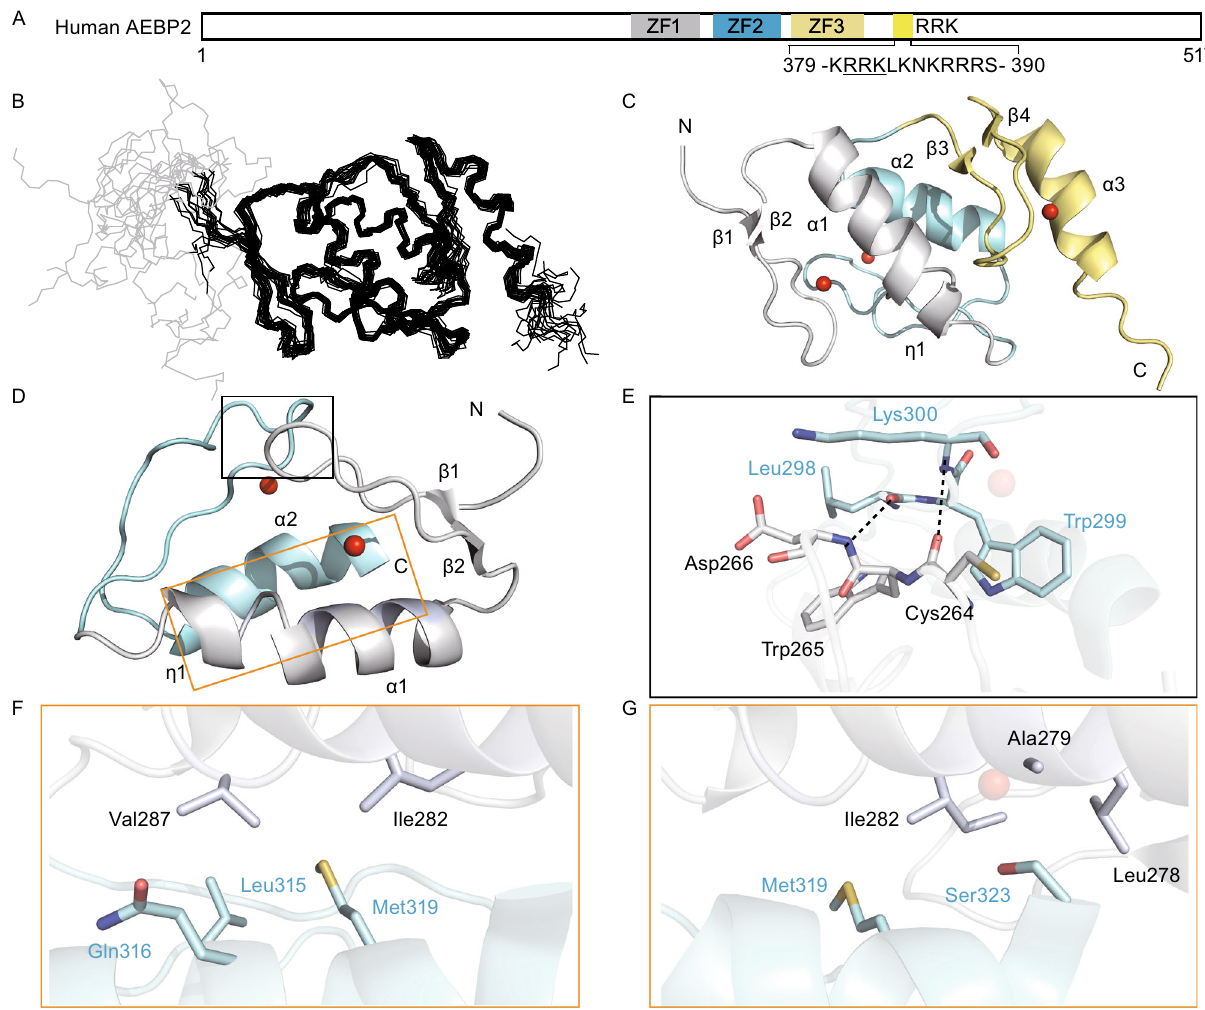
Figure 1. All three zinc fi ngers of AEBP2 are composed of Cys2His2 zinc fi ngers . (A) Schematic representation of the human AEBP2 protein, including the three zinc fi ngers and RRK rich motif. The fi rst zinc fi nger is shown in gray bar, second in light blue bar and third in light yellow, respectively. The RRK rich motif is shown in yellow bar, with sequence shown as single letter amino acids. (B) Stereo image of the 20 lowest energy ZF1 – 3 backbone structures (PDB ID: 5Y0U). The overall structure is depicted, with the His 6 - tag shown in gray. (C) Cartoon representation of ZF1 – 3 highlights the secondary structural elements, color scheme as for (A), and spheres are zinc ions. (D) Overview of ZF1 – 2 packing as tCWCH2 domain. The inter-zinc fi nger interaction regions are squared with gray line and orange line, respectively. (E) Detail view of the loop region. The residues involved inter-zinc fi nger interactions are shown in sticks. Hydrogen bonds are delineated by black dashed lines. (F and G) Detail view of the helix region. The residues involved inter-zinc fi nger interactions are shown in